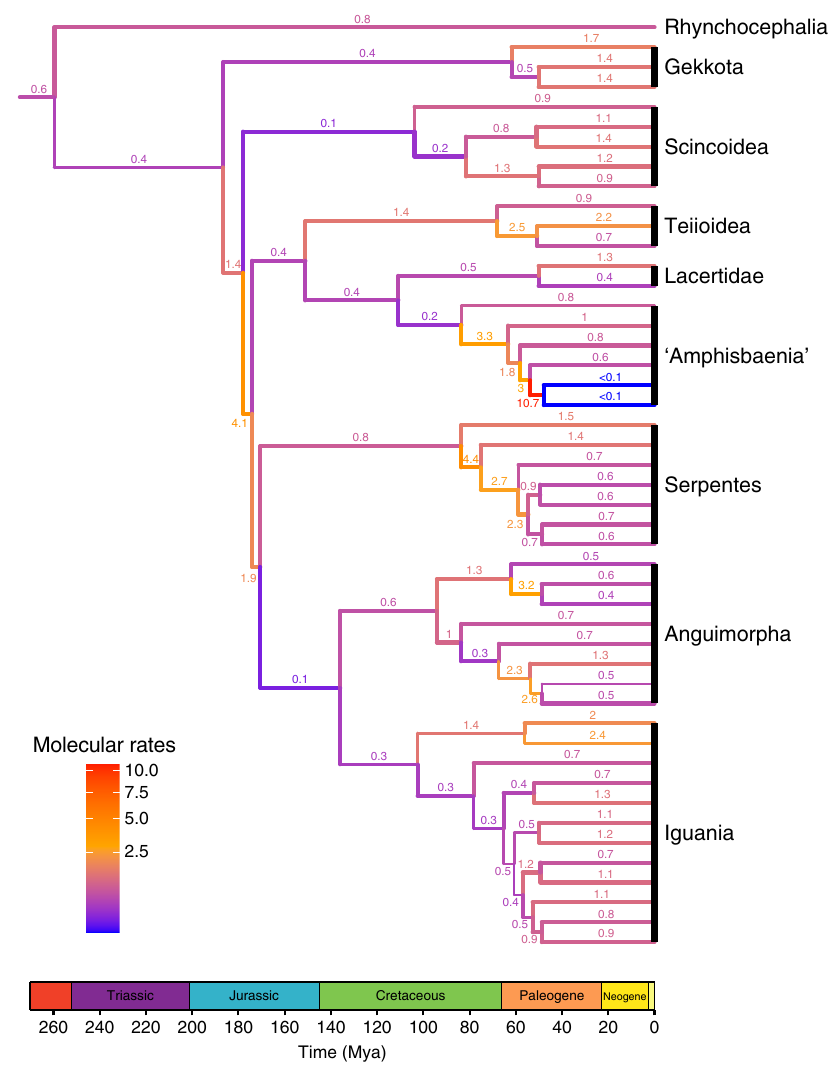
Fig. 4 Relative molecular rates of evolution in lepidosaurs. Branch widths proportional to posterior probabilities for clades stemming from the respective branches. Molecular rates are plotted for all sampled extant taxa and internal branches until their most recent common ancestor. For full tree and rate values see Supplementary Figs. 5,